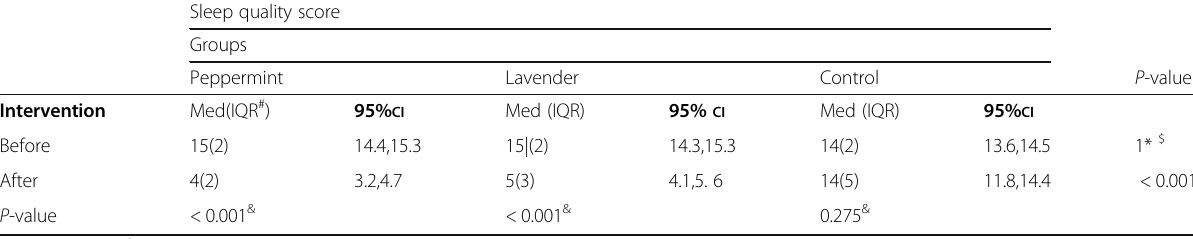
Table 2 Comparison of the sleep quality before and after the intervention in study groups Sleep quality score Groups